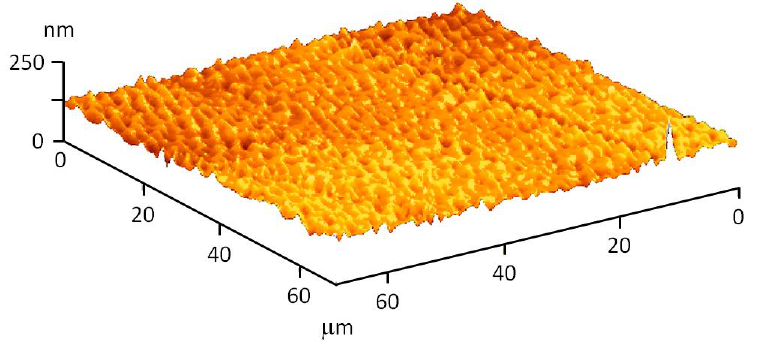
Figure 6. AFM surface topography of a composition based on borosiloxane and silver oxide nanoparticles.